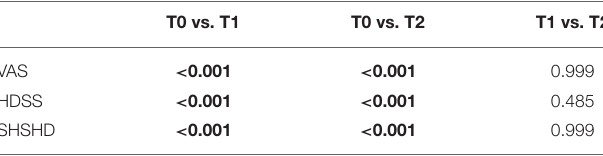
TABLE 3 | Post-hoc pairwise comparisons of the scores using Bonferroni’s method. T0 vs. T1 T0 vs. T2 T1 vs. T2 VAS < 0.001 < 0.001 0.999 HDSS < 0.001 < 0.001 0.485 SHSHD < 0.001 < 0.001 0.999 Bold values denote statistical